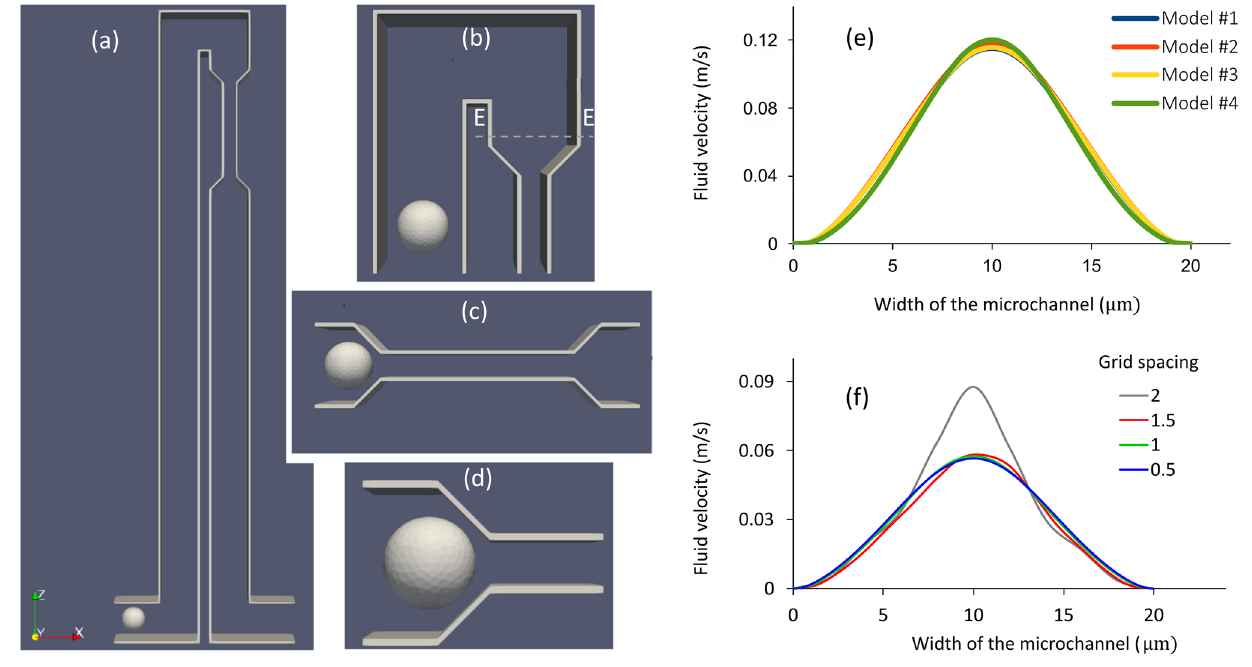
Figure 1. Investigations for selecting a computationally efficient geometrical domain to simulate the passage of cancer cells through a microchannel. The selected geometrical domain would be used in the computationally expensive parameter-identification process. Four different models were investigated: ( a ) Model #1: the entire microchannel setup used in experiments of Byun et al. 9 , ( b ) Model #2: part of the entire microchannel setup of Model #1, ( c ) Model #3: the entire constriction part of Model #1, ( d ) Model #4: the entry part of the constriction of Model #1, ( e ) Comparison of fluid velocities at the depth of 7 µm of the microchannel at cross-section E–E in ( b ) for the four models, and ( f ) The fluid velocity with different lattice grid spacing sizes for the flow rate of 22.8 µL/h at the cross section E–E shown in panel ( b ). Fluid flow is not sensitive to the grid spacing size for the grid spacing of 1.5 µm and finer.